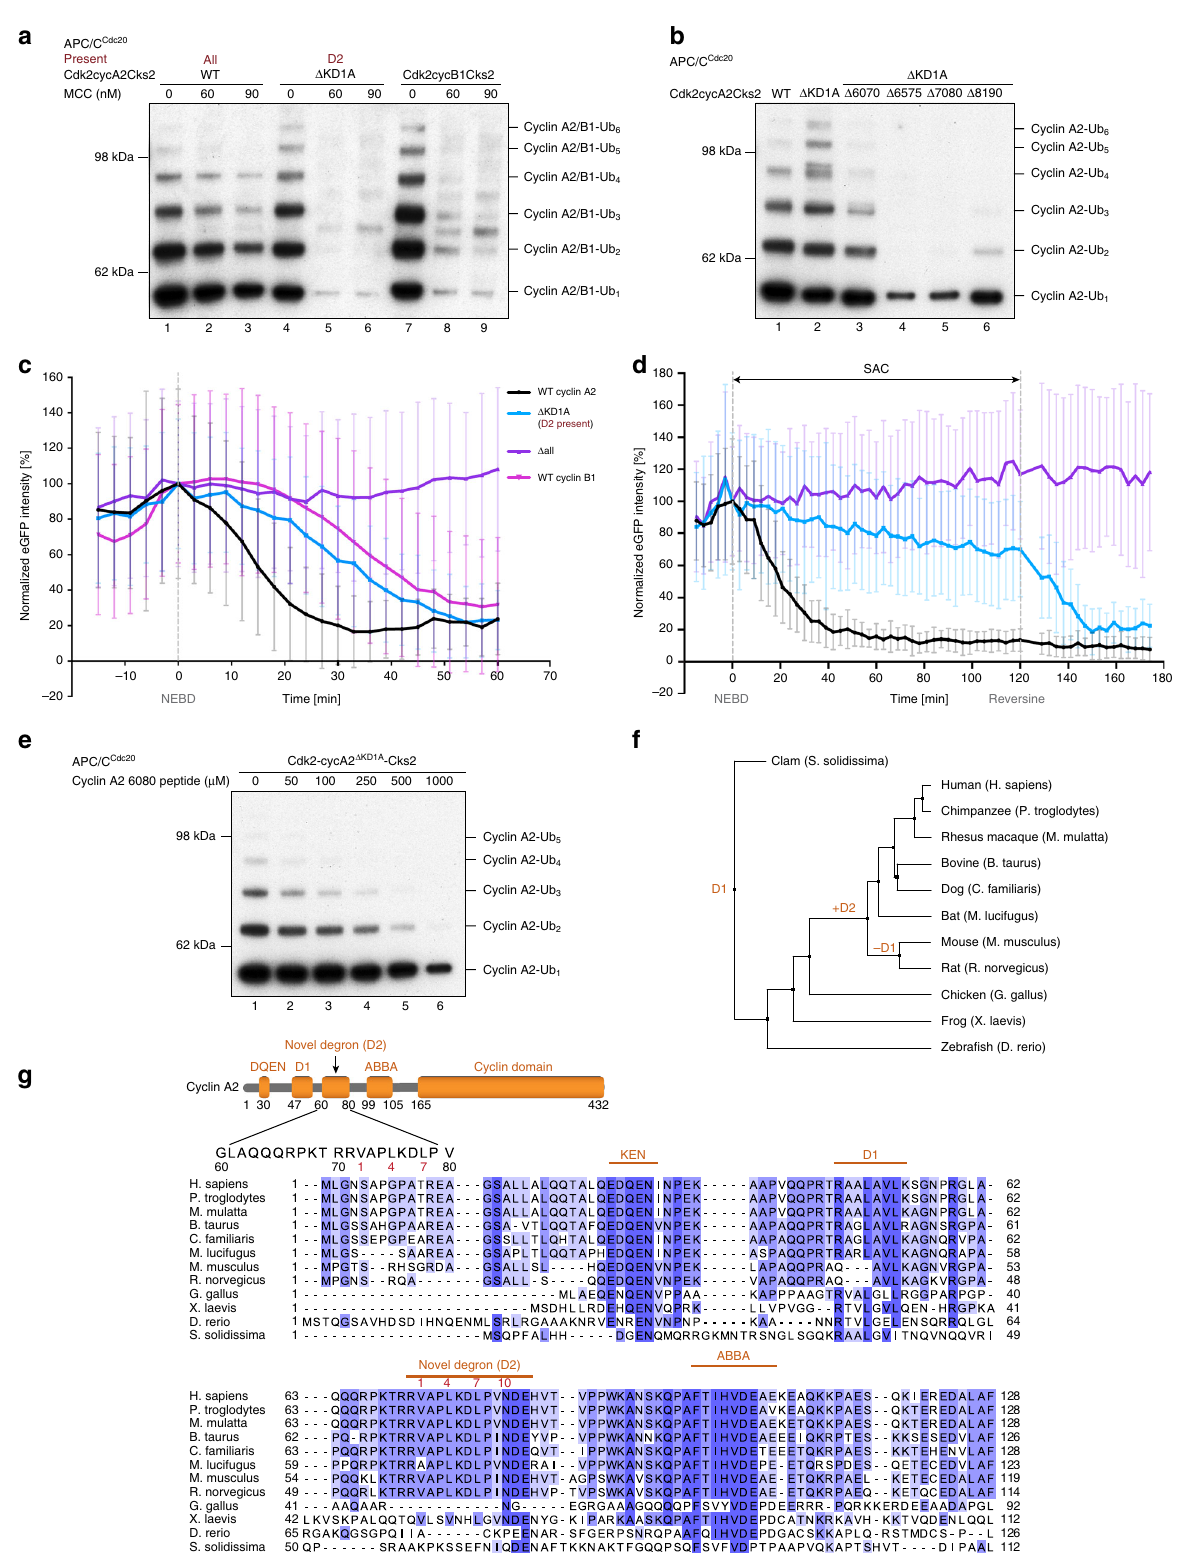
Cdc20 WD40 and Apc10 was observed (Fig. 4c), identifying this density as the D2 box. In complexes of APC/C Cdc20 with both wild-type Cdk2-cyclinA2-Cks2 and Cdk2-cyclinA2 Δ D1 -Cks2, the D2 box forms a C-shaped loop connecting Cdc20 WD40 and Apc10 (Fig. 4b, c), resembling the Hsl1 D box that is bound to APC/C Cdc20 (ref. 48 ) (Fig. 4g). In contrast, the D1 box class of